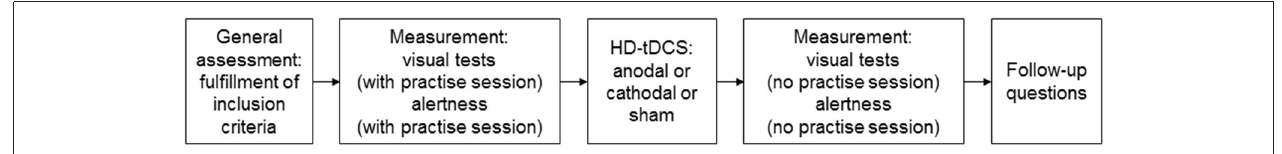
FIGURE 1 | Experimental design of the single blind within-subject, sham controlled randomized cross-over trial.